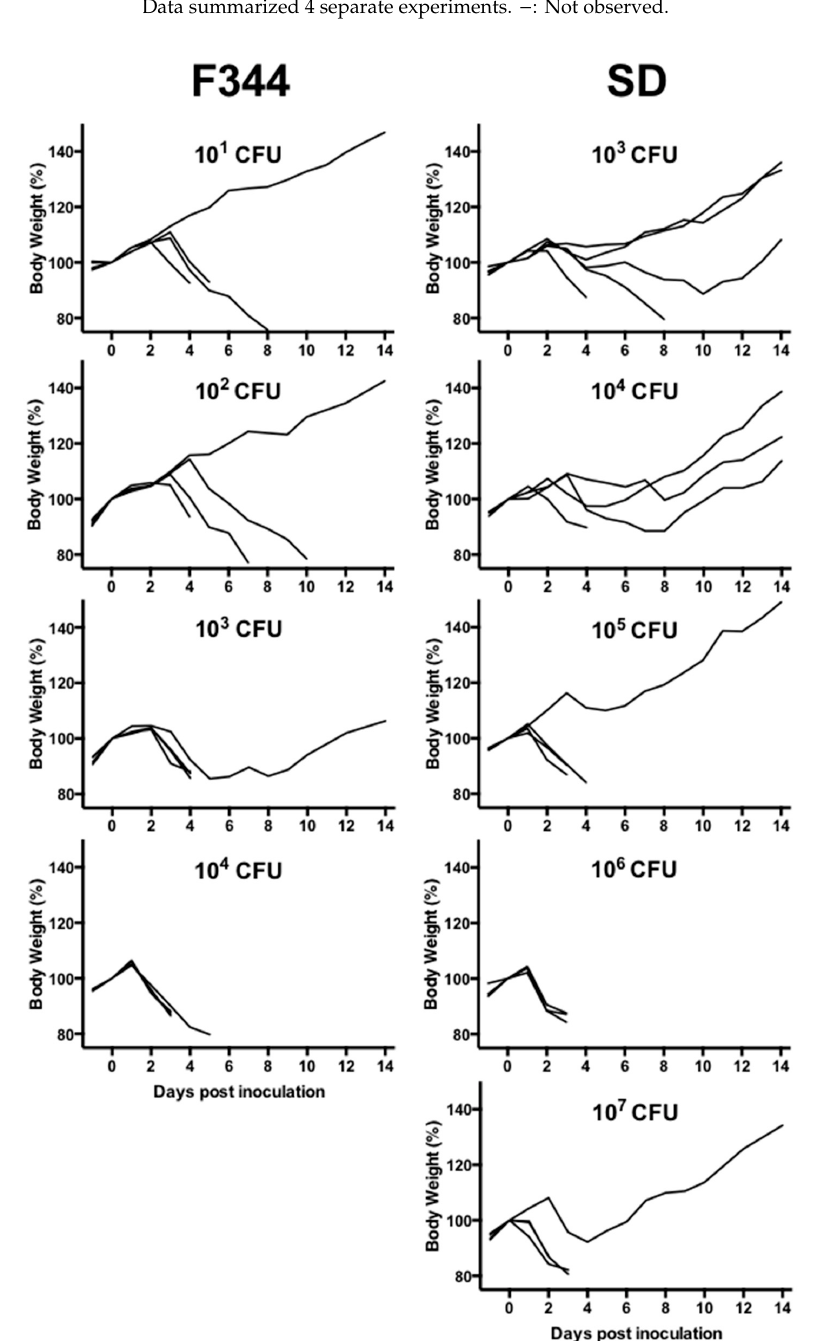
Figure 2. Changes in body weights of rats inoculated with Francisella tularensis . F344 and SD rats ( n = 3–5) were inoculated with NVF1 intraperitoneally. Challenge doses are given in each graph in colony-forming units (CFUs). The graph shows the percent change in body weight relative to day 0 post inoculation for each animal. Data summarized 3 separate experiments.